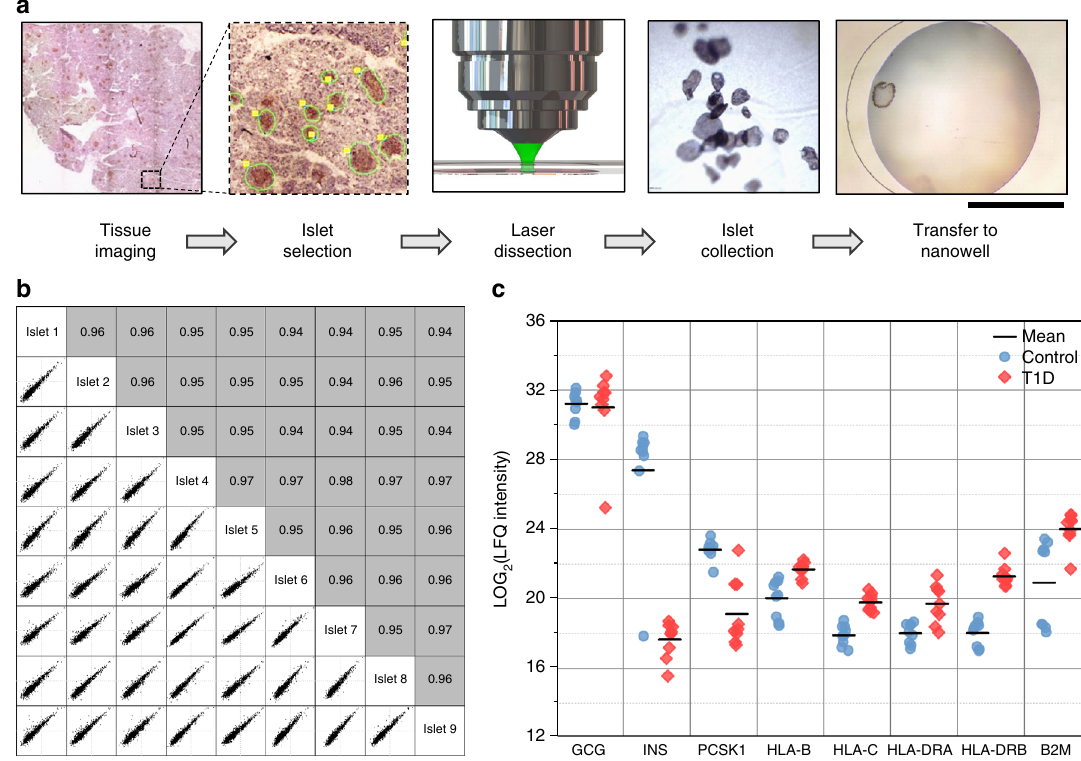
Fig. 5 Proteomic pro fi ling of single human pancreatic islet sections. a Schematic work fl ow showing the identi fi cation, laser microdissection, collection, and transfer of human islet sections into nanowells. b Pairwise correlation analysis of protein expression level in nine human islet sections from a non-diabetic donor. c Comparison of protein abundances in single islet sections between a non-diabetic donor (control) and a T1D donor. Scale bar is 500 µ